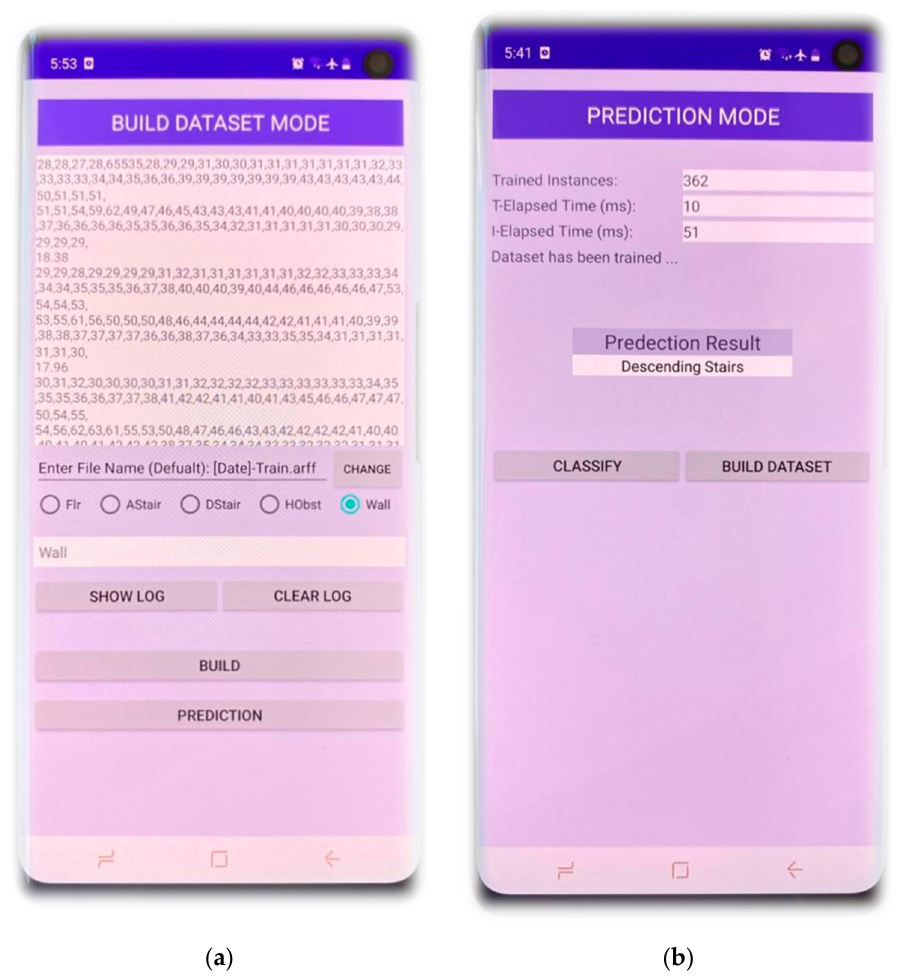
Figure 10. LidSonic smartphone app ( a ) data stream view of the build dataset mode; ( b ) prediction mode view of the dataset mode.